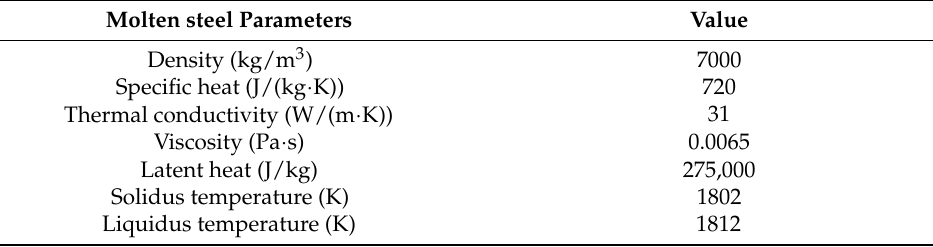
Table 2. Physical parameters used in mathematical simulation